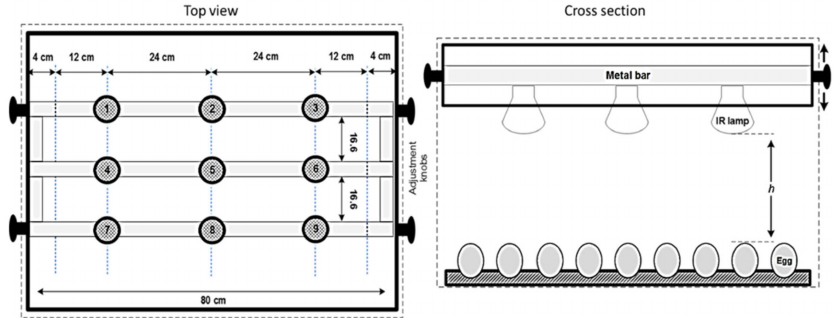
Figure 2. Schematic representation of the infrared cover showing the nine IR lamps (top view graph) and the adjustable distance from the eggs (h) using the adjustment knob (cross section graph).